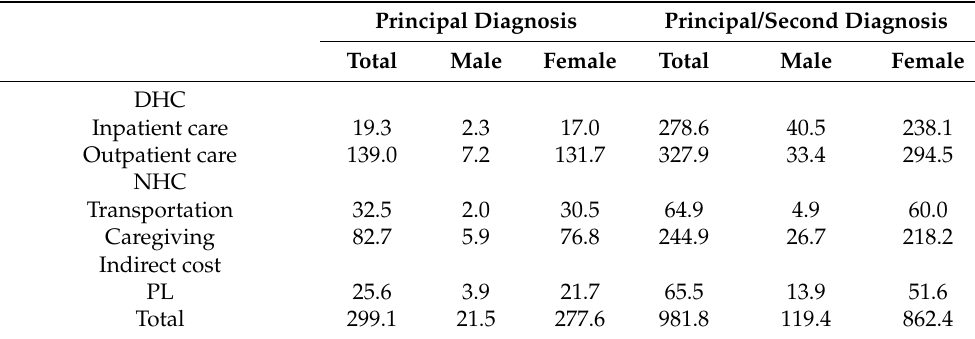
Table 2. Socioeconomic costs of osteoporosis by cost components in 2017